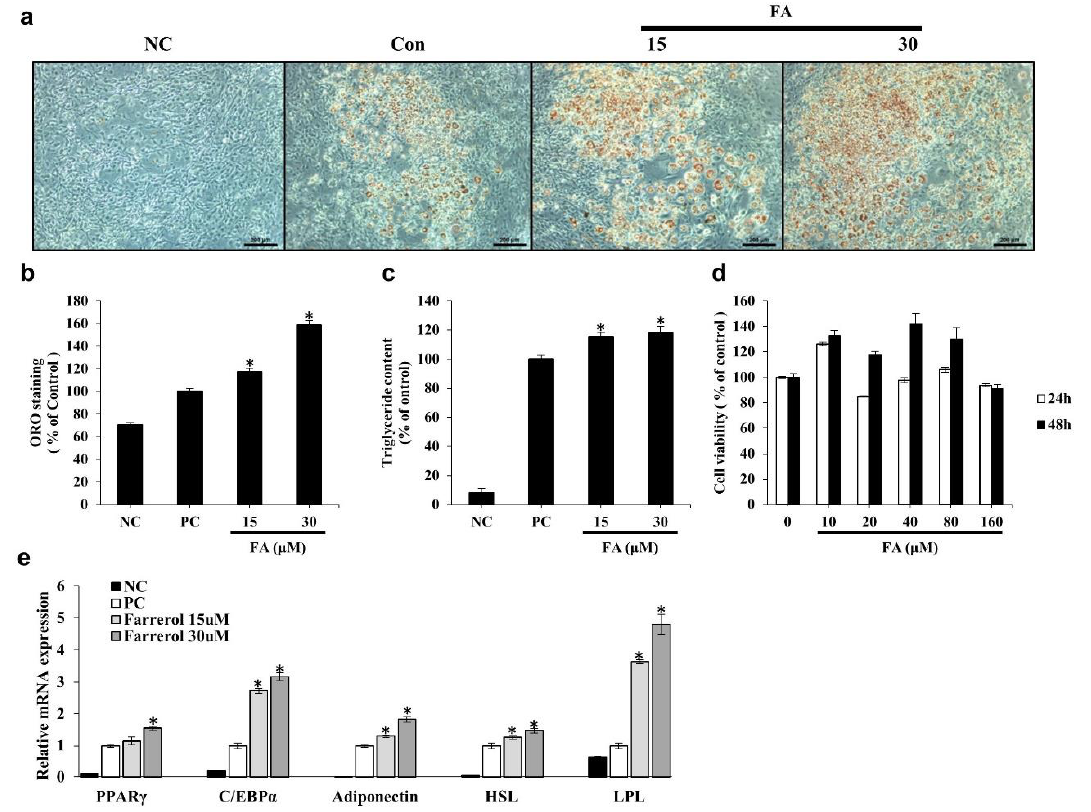
Figure 7. Effects of farrerol (FA) on lipid accumulation, triglyceride content, and adipogenic differentiation in 3T3-L1 cells. ( a ) First, 3T3-L1 preadipocytes were treated with differentiation medium in the presence or absence of FA at 15 or 30 μg/mL for 8 days. Lipid accumulation was quantified by staining with Oil Red O (ORO) solution and absorbance was measured at 495 nm. Differentiated 3T3-L1 cells photographed at 100× magnification after ORO staining. ( b ) Quantification of ORO-stained intracellular lipid content. ( c ) Intracellular triglyceride content quantified by a triglyceride assay kit and assessed at 570 nm. Preadipocytes were used as negative controls (NC), whereas fully differentiated adipocytes were used as positive controls (PC). ( d ) Cell viabilities were determined with an MTT assay. ( e ) The 3T3-L1 preadipocytes were treated with FA at the indicated concentrations for 24 or 48 h. The relative mRNA expression levels of PPARγ, C/EBPα, adiponectin, HSL, and LPL were assessed by real-time PCR. Each experiment was repeated in triplicate. Bars represent means ± standard error (*, p < 0.01 compared to control group).